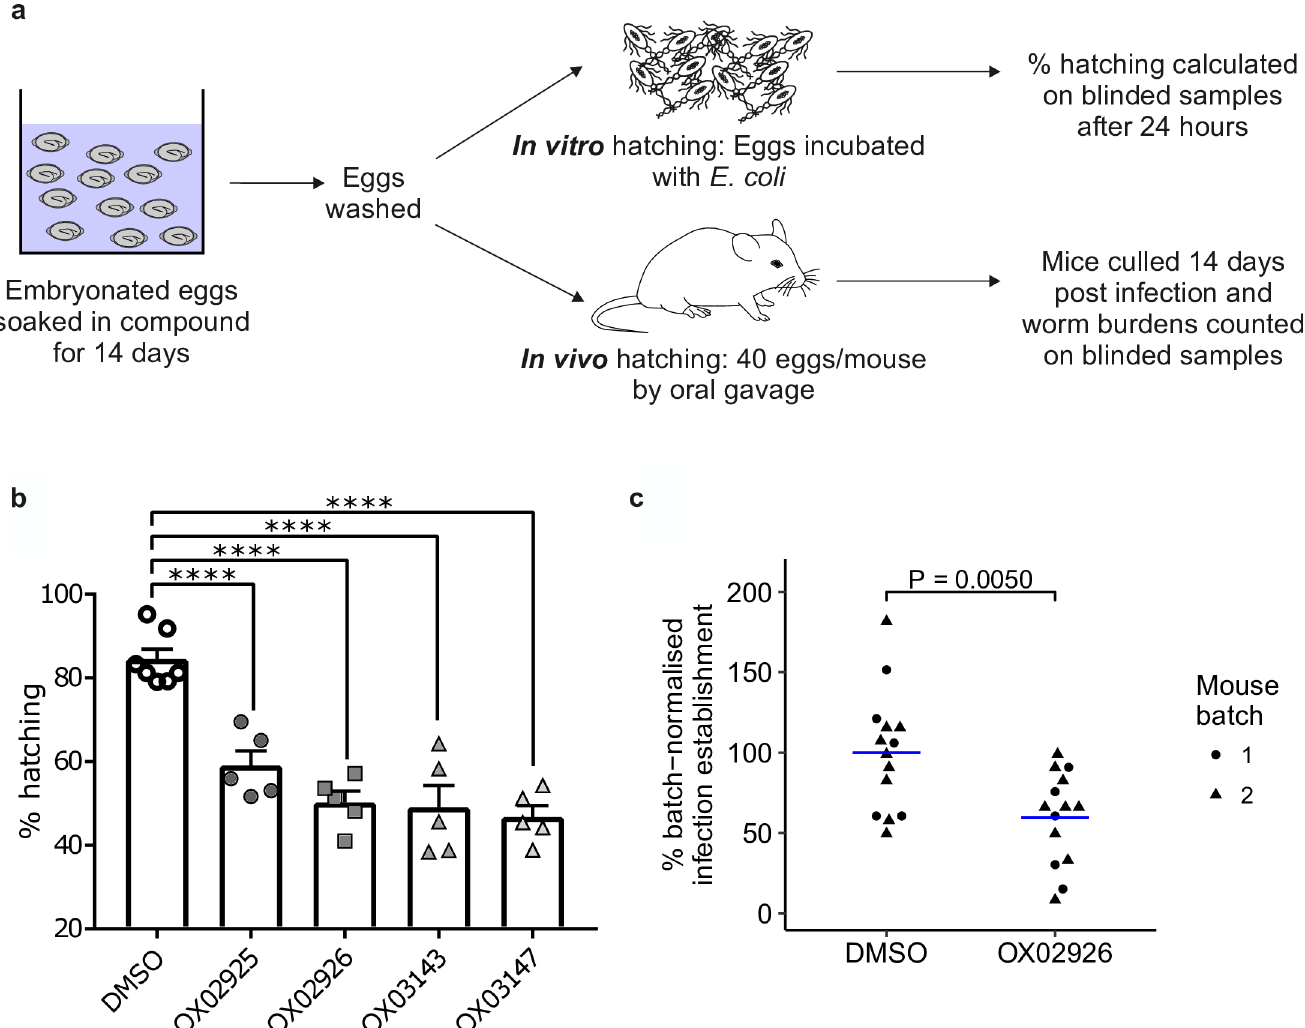
Fig 6. Reduced worm burden in mice given T . muris eggs that had been treated with diaminothienopyrimidines. (a) Embryonated eggs were soaked in compound for 14 days, washed in water and then used in either in vitro or in vivo hatching assays. (b) Treatment with DATPs reduced the ability of embryonated eggs to hatch in E . coli bacterial suspension after 24 hours. A one-way ANOVA showed a significant difference between treatment groups (F(5,26) = 25.95 p < 0.0001) with a post-hoc Dunnett’s compared to DMSO control ( (cid:3)(cid:3)(cid:3)(cid:3) = p < 0.0001) n = 7 (DMSO), n = 5 (DATP compounds) (c) SCID mice were infected with 40 eggs and worm burden assessed at day 15 post infection. The experiment was carried out in two batches, with n = 5 and n = 9 mice respectively in each of the control and treatment groups. Data were normalised for each batch relative to the mean of the DMSO-only control group for that batch. Blue line indicates mean for each treatment group. A two-way ANOVA showed a significant effect of treatment [F(1,24) = 9.569, P = 0.00497] but no effect of batch [F(1,24) = 0.083, P = 0.77618] or interaction [F(1,24) = 0.083 0.77618]. A post-hoc Tukey HSD test showed that the OX02926 -treated group was significantly different from the DMSO control group (P =